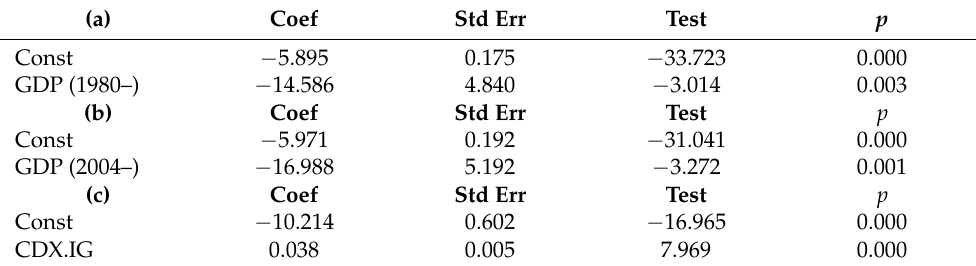
Table 3. Rating Baa: model parameter estimates and p -values.